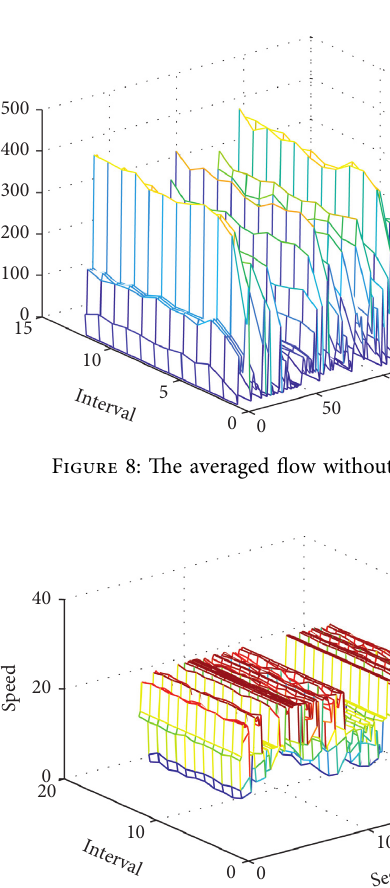
Figure 9: The averaged speed without control.